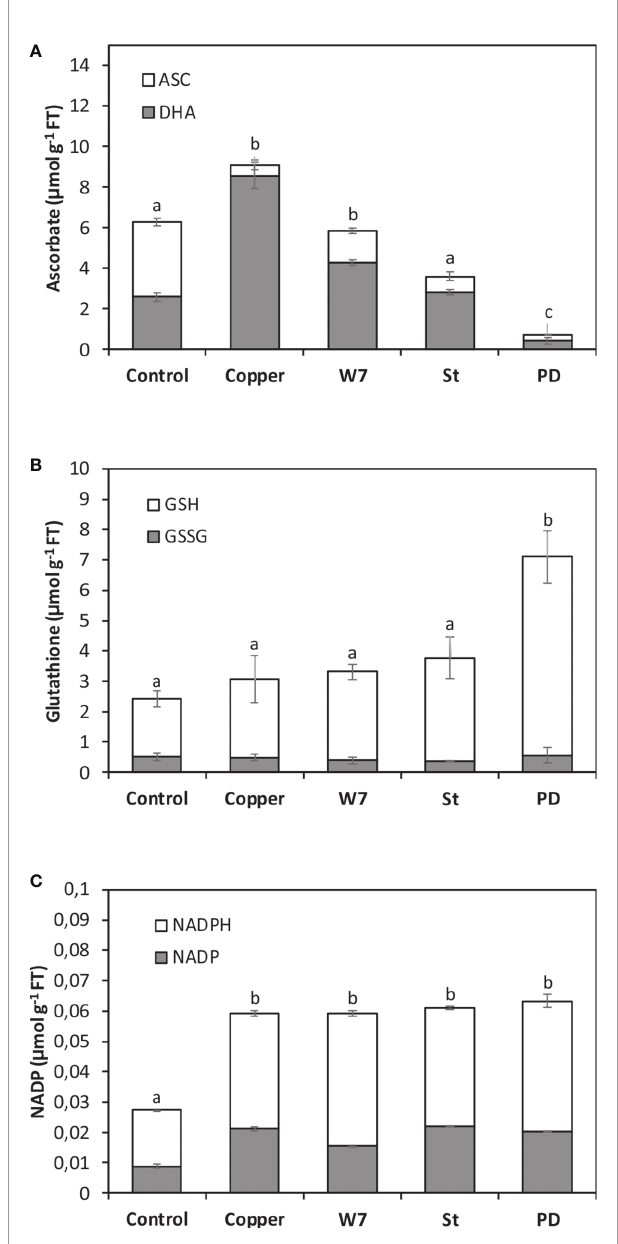
FIGURE 5 | Level of total ascorbate (ASC, A ), total glutathione (GSH, B ) and total NADPH ( C ) corresponding to ASC, GSH and NADPH levels (white bars) and dehydroascorbate (DHA), oxidized glutathione (GSSG) and NADP (black bars) in U. compressa cultivated in seawater without copper addition for 5 days, with 10 µM of copper for 5 days, and with 100 µM of W-7, 10 µM staurosporine (St), with 5 µM of PD-98059 (PD) and 10 µM copper for 5 days (hashed bars). Levels of ASC, DHA, GSH, GSSG, NADPH and NADP are expressed in micromoles per gram of fresh tissue (FT). Bar represent mean values of three independent experiments. Different letters indicate signi fi cant differences among mean values (±SD) ( P <